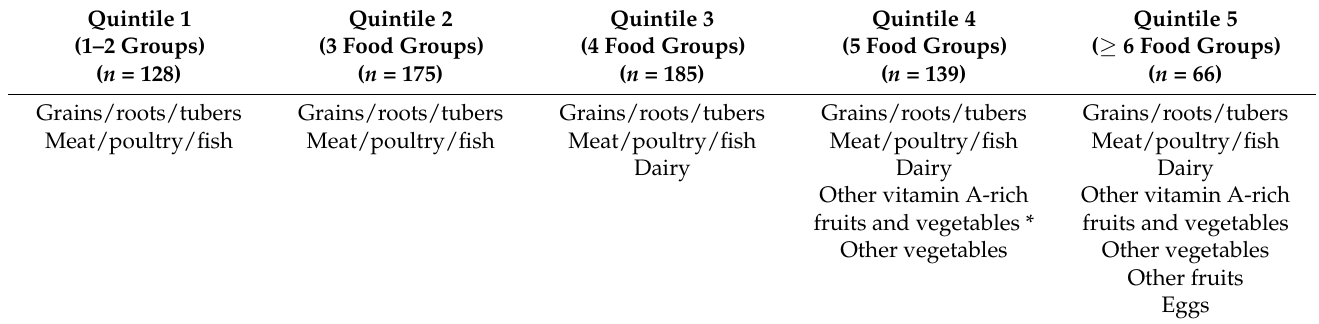
Table 2. Food groups consumed by more than 50% of participants per dietary diversity score quintile for the total study